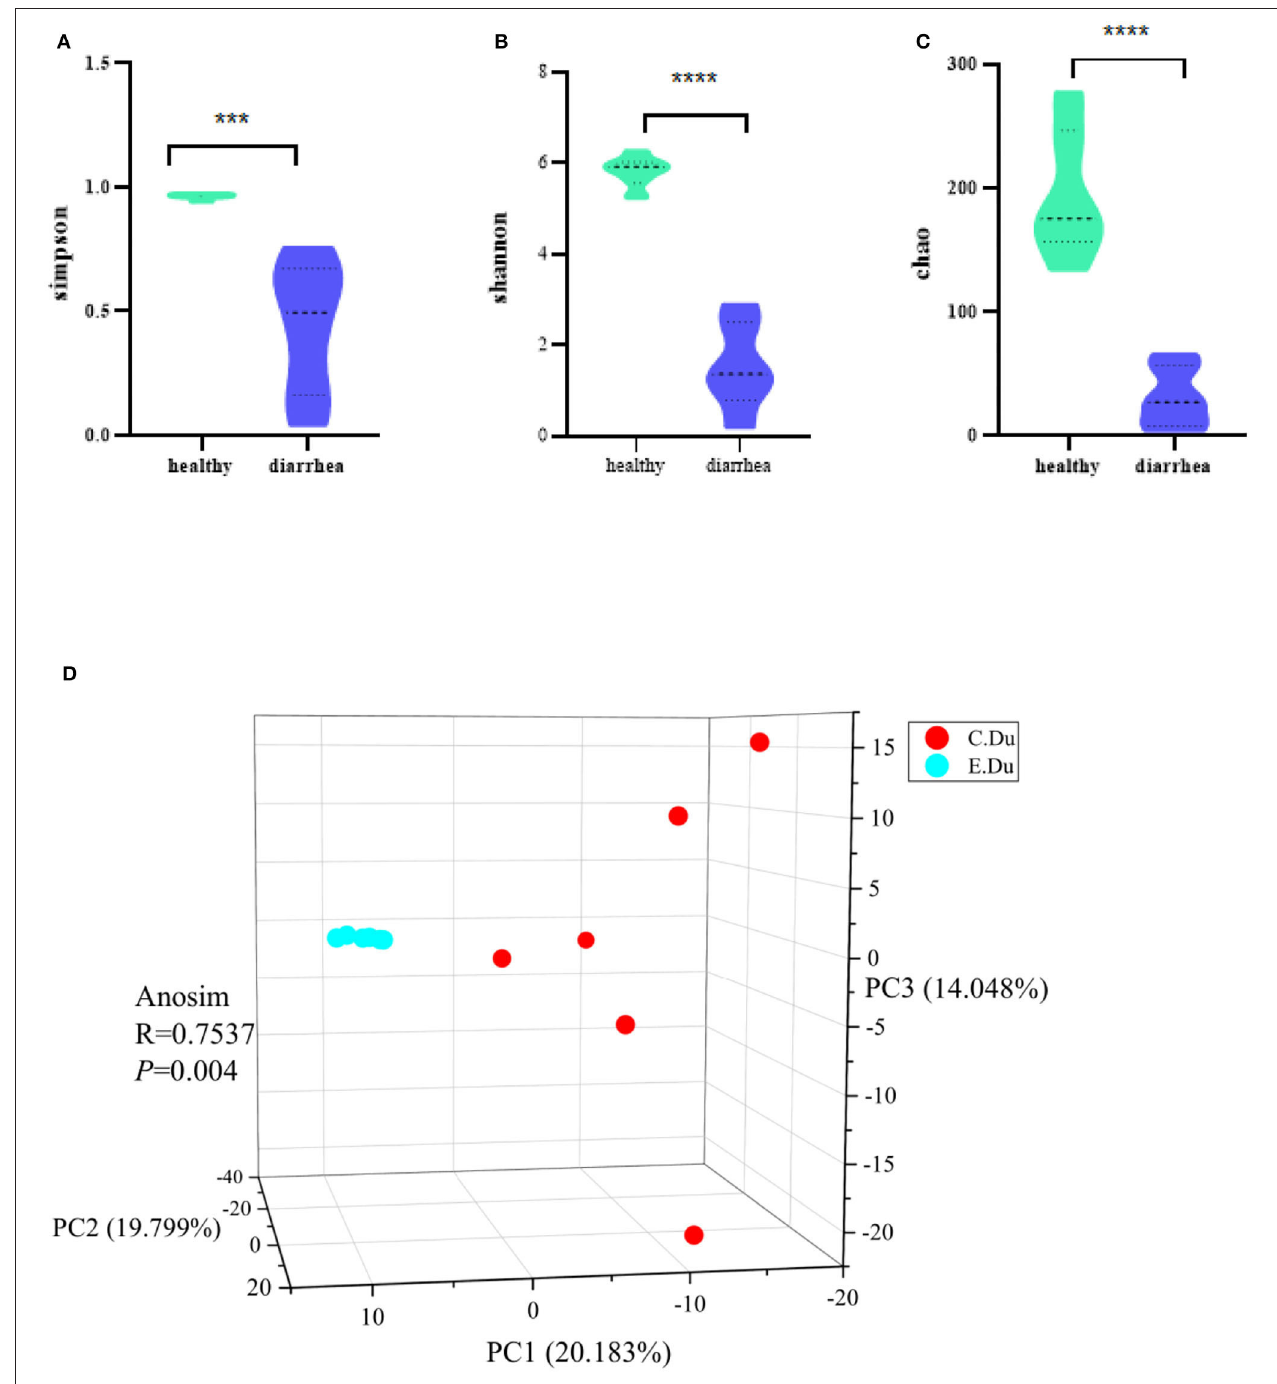
FIGURE 2 | Gut microbial diversity in healthy and diarrhea rabbits. Alpha diversity was evaluated based on the Chao (A) , Simpsoneven (B) , and Shannon (C) indices of the OTU levels. *** P < 0.05, **** P < 0.001. Principal coordinate analysis of beta-diversity was based on the weighted UniFrac (D) analyses of the OTU levels. C. Du, healthy; E. Du,